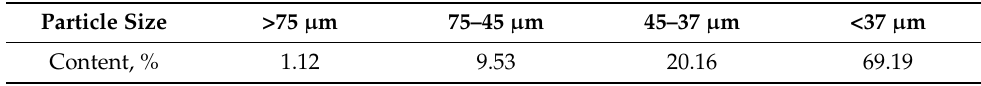
Table 2. Particle size distribution of mineral